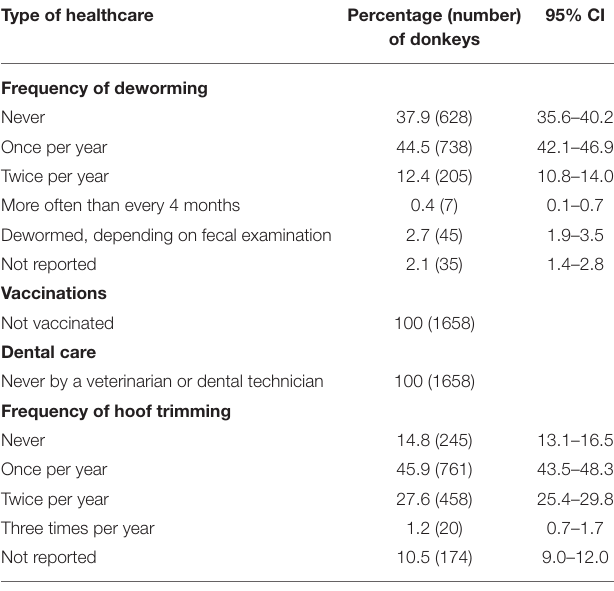
TABLE 8 | Health care of donkeys across smallholder farms in Western Liaoning and Eastern Inner Mongolia of China ( n = 1,658). Type of healthcare